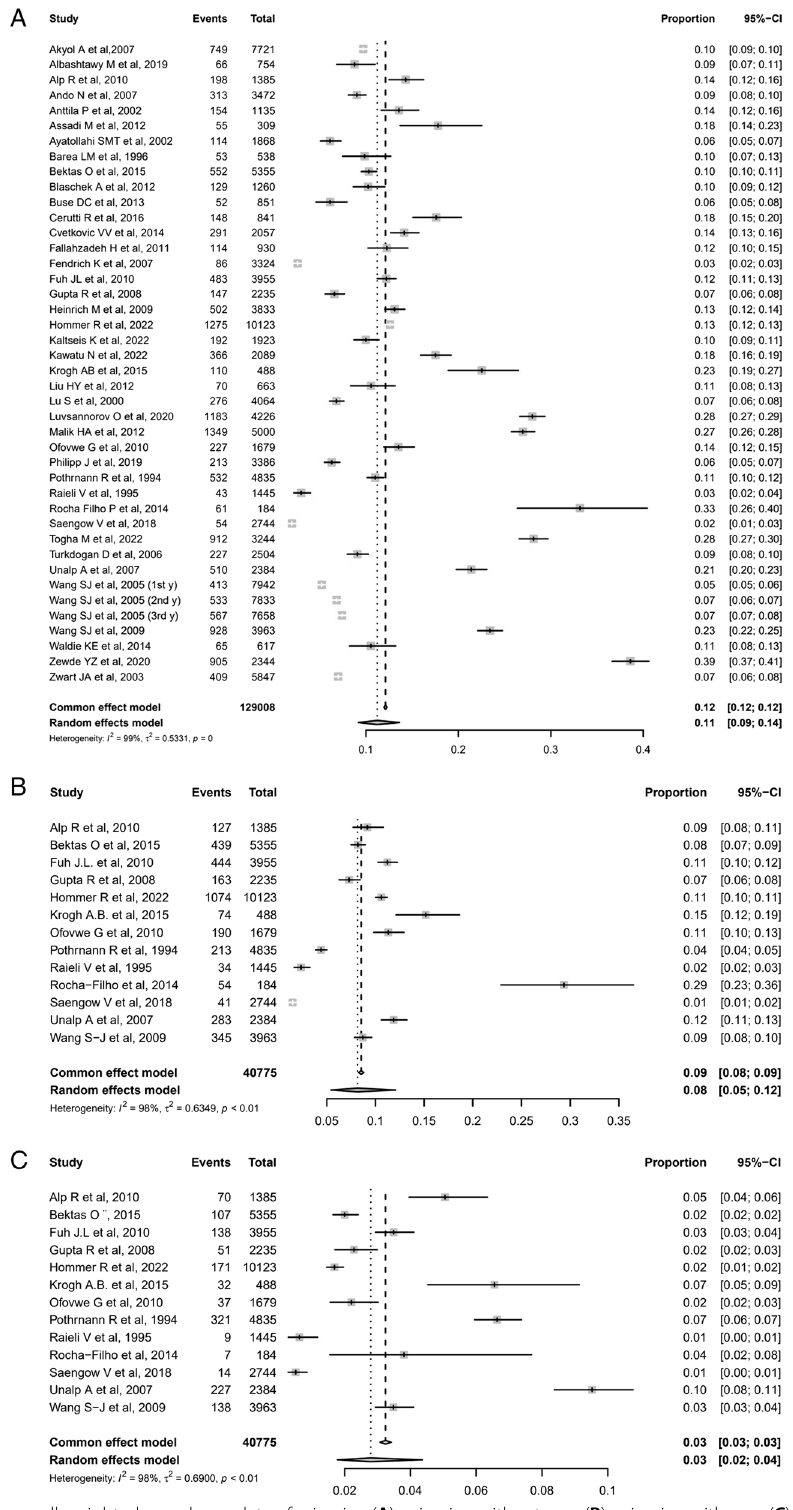
Fig. 3 Forest plot of the overall weighted prevalence data of migraine ( A ), migraine without aura ( B ), migraine with aura ( C ). Total: total population sample; Events: number of primary headache diagnosis; CI: Confidence